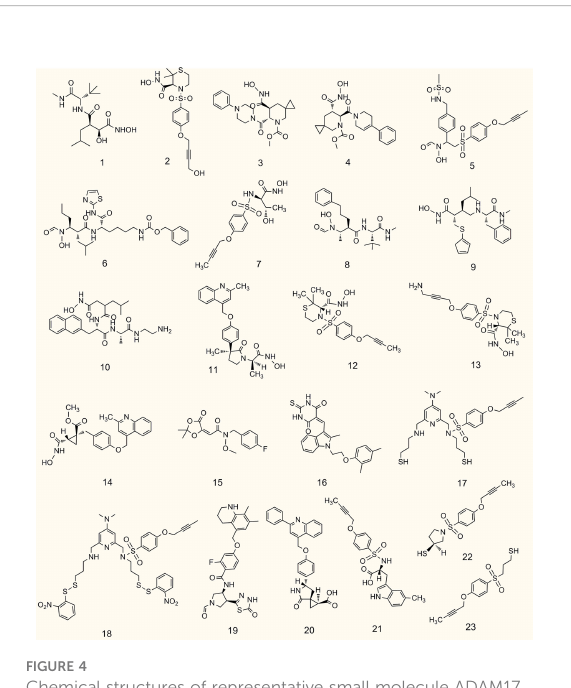
Figure 3, endothelial cells secrete a series of adherent molecules,